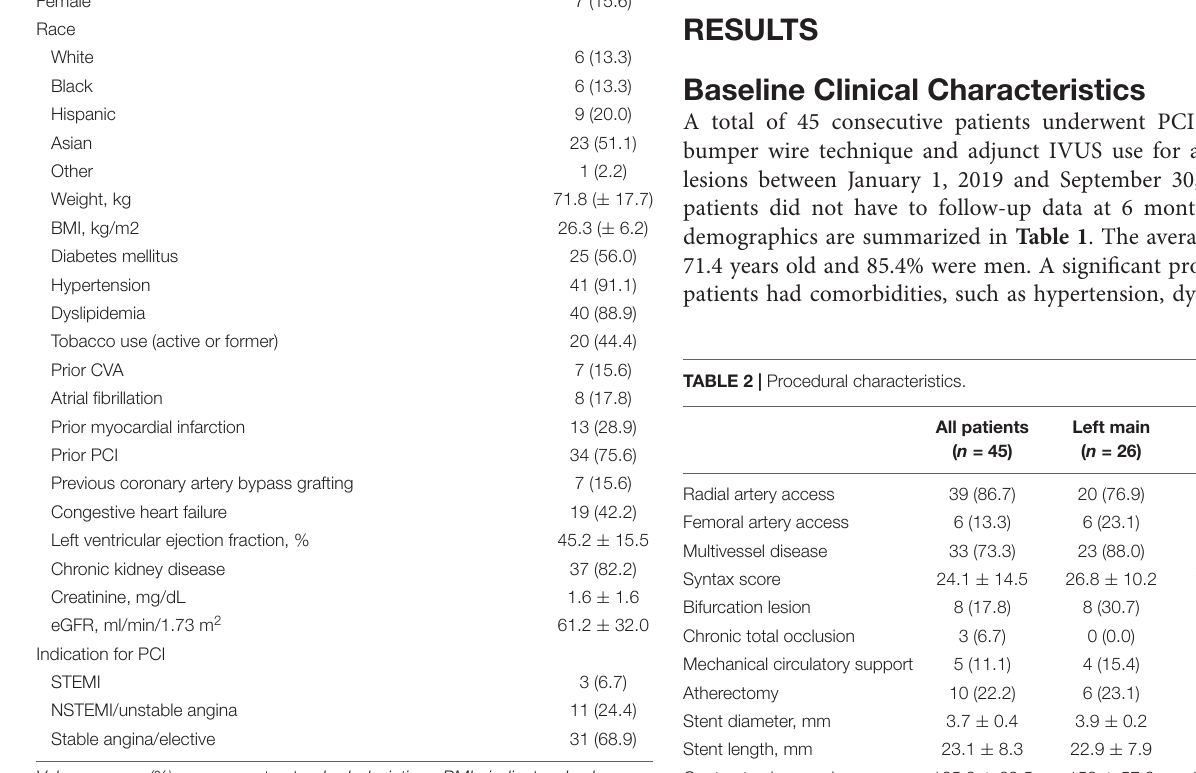
well as all-cause death, stroke (ischemic or hemorrhagic), and